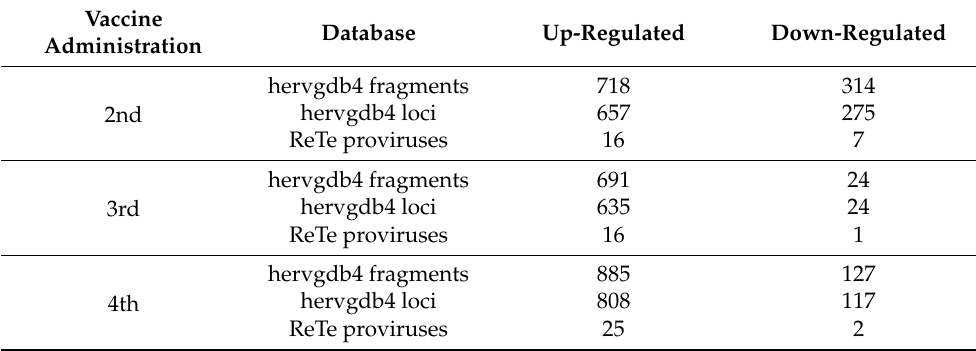
Figure 4. Differential HERV/MaLR expression after vaccine administrations. Volcano-plot of the differentially expressed hervgbd4 fragments (red dots) after the 2nd, 3rd and 4th vaccine administra- tion are shown in ( a ), ( b ), and ( c ), respectively. Each dot represents individual hervgbd4 fragments, which spread according to the log2 fold change ( x -axis), and the log10 adjusted p -values ( y -axis). Table 2. Overview of MaLR/HERVs modulation after vaccine